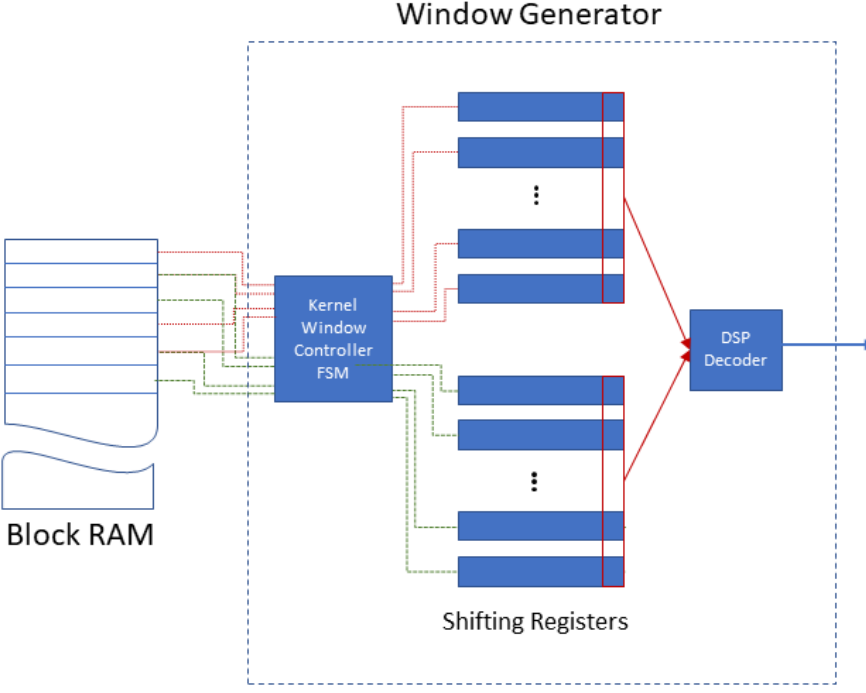
Figure 1. Input block